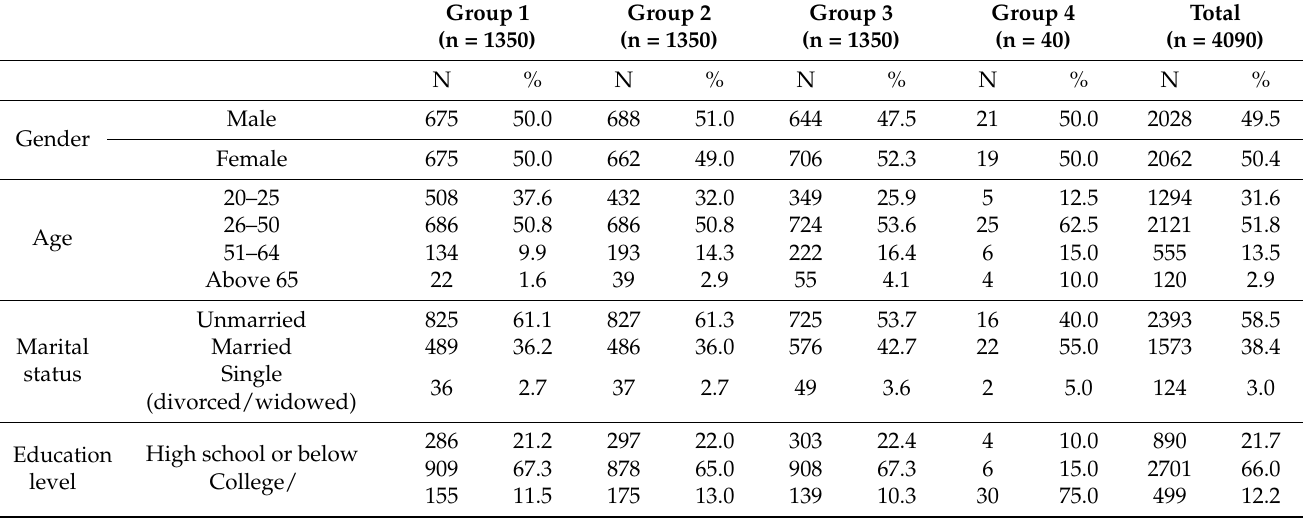
Table 1. Demographic Information of Research